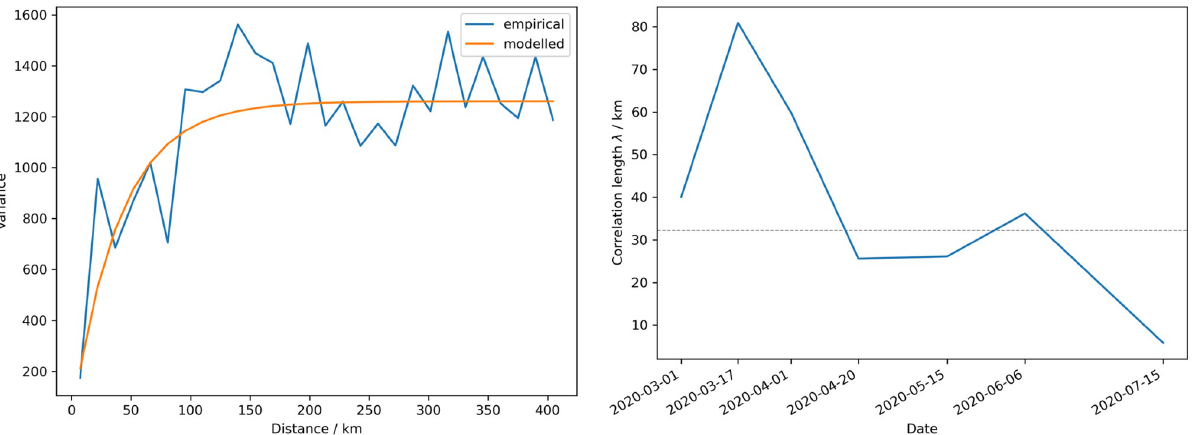
Fig 6. Results from the variogram analyses. The empirical and the exponential variograms Eq (9) of the cumulative rates of the reported cases for the time period before the first NPI are shown in the left panel. The time evolution of the correlation lengths λ cases is shown in the right panel. The mean distance of the neighboring district centroids is indicated by the dashed grey